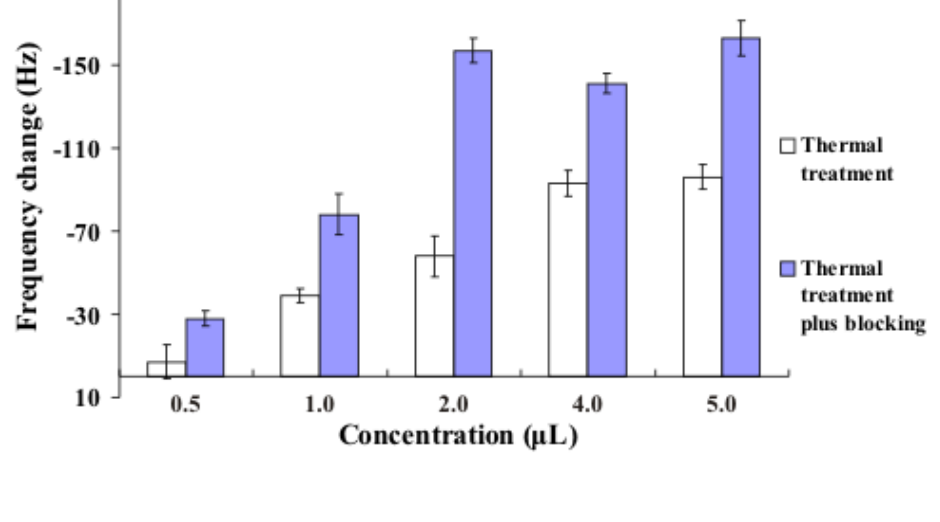
Figure 3. Resonant frequency change of DNA solution. Btg I ( Bst DSI)-digested IS 6110 of M. tuberculosis genomic DNA was diluted with hybridization buffer before hybridization assay on piezoelectric biosensor. Each data point represents the mean ± SD (n =